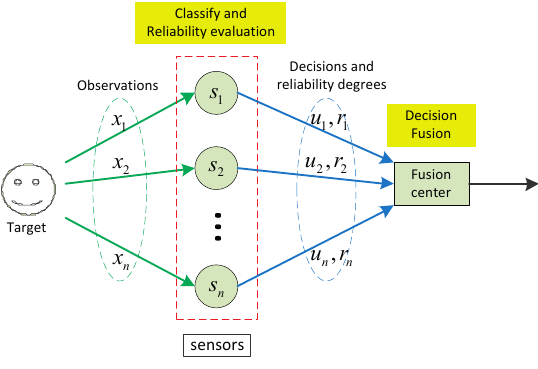
Figure 1. System model of the proposed decision fusion